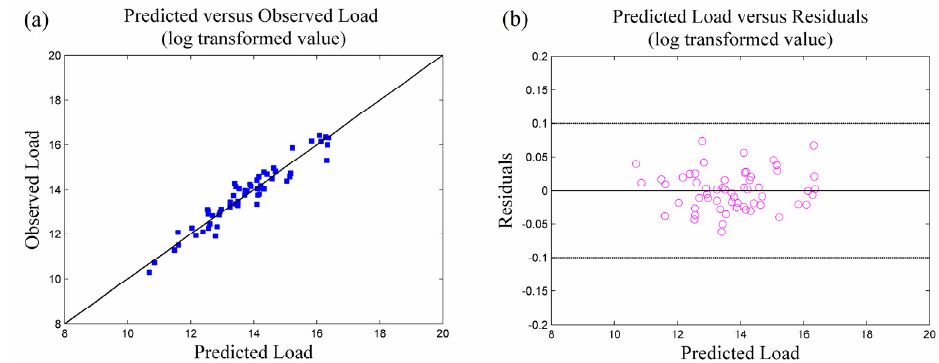
Figure 5. Scatterplots of ( a ) predicted values versus observed values and ( b ) residuals in PLB.